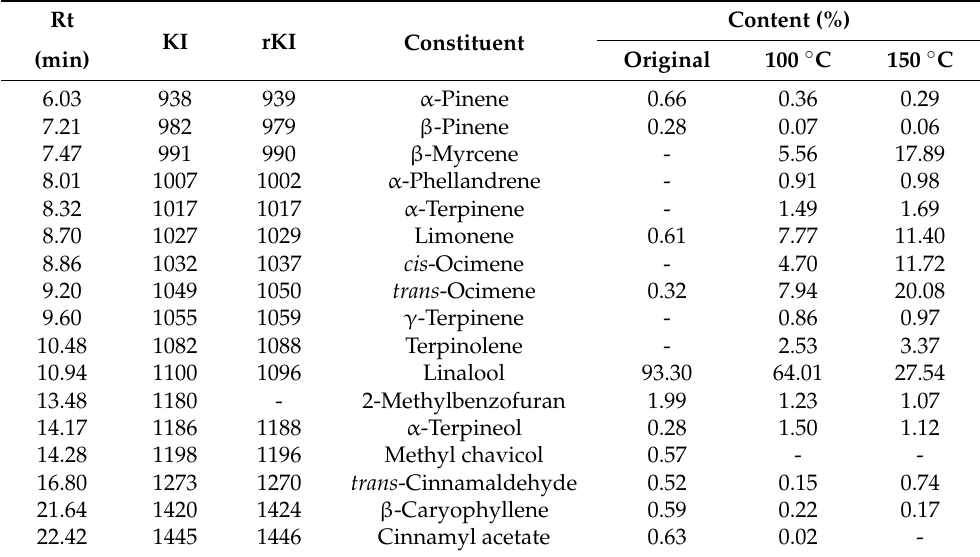
Table 1. Compositions of linalool-chemotype Cinnamomum osmophloeum leaf essential oil after thermal degradation.